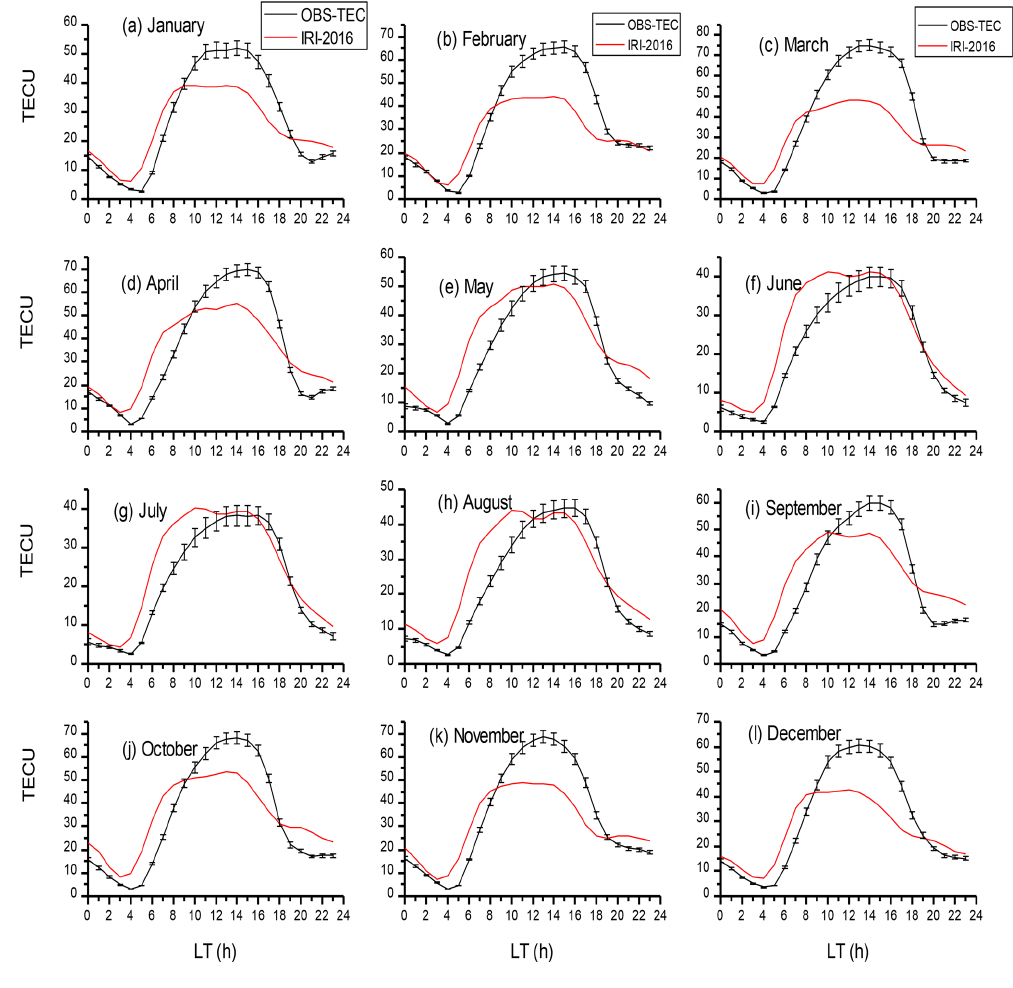
Figure 4. Same as Fig. 1 but for 2014. Table 2. Months of daytime estimate of IRI-2016 model in NEI (source: